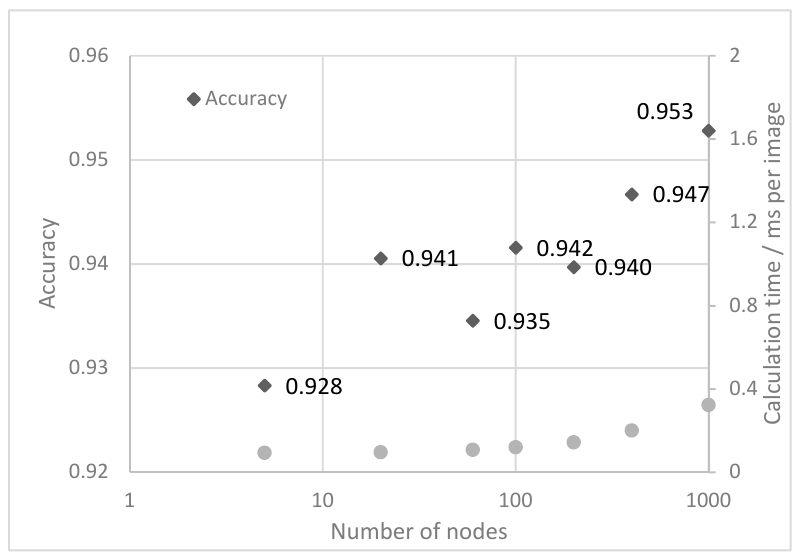
Figure 7. Accuracy of the basic neural network as a function of nodes per fully connected layer.